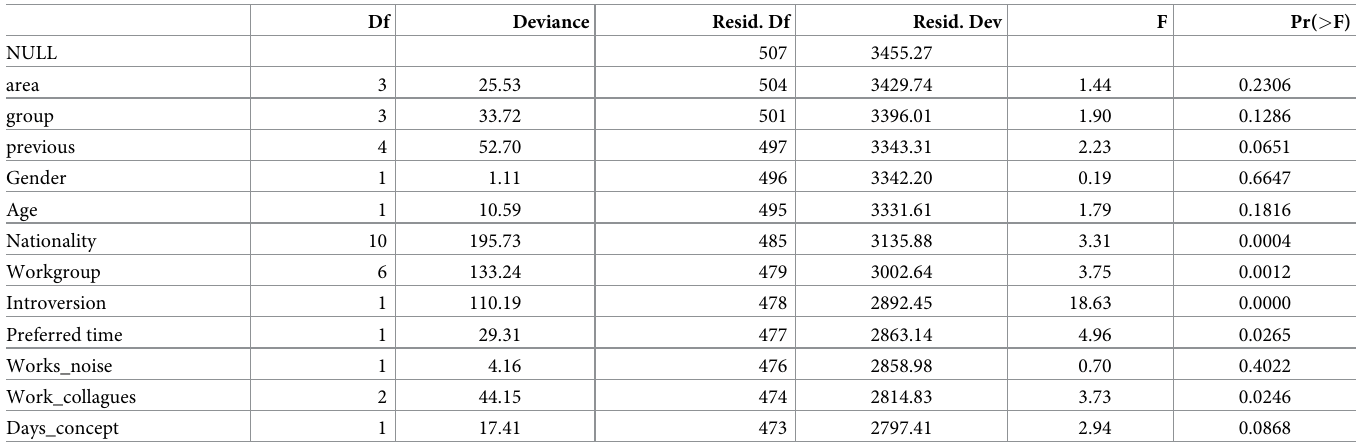
Table 15. ANOVA table for